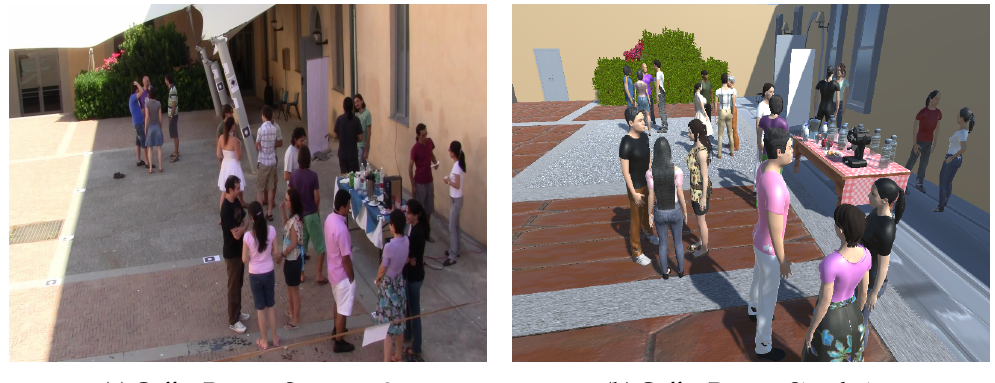
Figure 7. Image ( b ) is the virtual scene of image ( a ), which is an original image from the coffee dataset. The similarities in image ( b ), with respect to image ( a ), could be seen as the floor, plants, walls with windows, doors, lamps, same amount of VAs as people, and their appearance. The table with machines for coffee and tea, glasses, snacks, and water bottles could also be seen image ( b ). The VAs in the simulation scene are created in such a way that their appearance resembles—i.e., make them appear as close as possible to—the people in the scene.